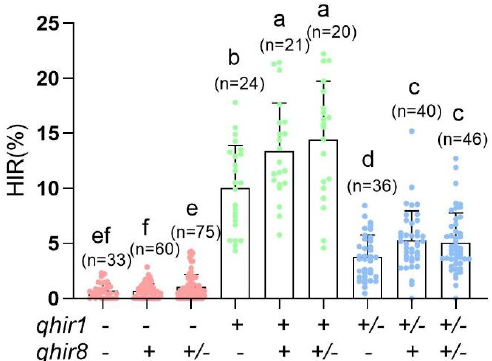
Figure 1. Haploid induction rate (HIR) values for the CAU6 NILs (near-isogenic lines) for nine genotypes. Di ff erent lowercase letters indicate a significant di ff erence at p < 0.05 (Tukey’s honestly significantly di ff erent (HSD) test). ( + ): presence of homozygous qhir1 / qhir8 allele from inducer lines; ( +/ -): presence of heterozygous qhir1 / qhir8 allele; (-): presence of homozygous allele at qhir1 / qhir8 from non-inducer line; n: number of ears used for calculating the HIR of each